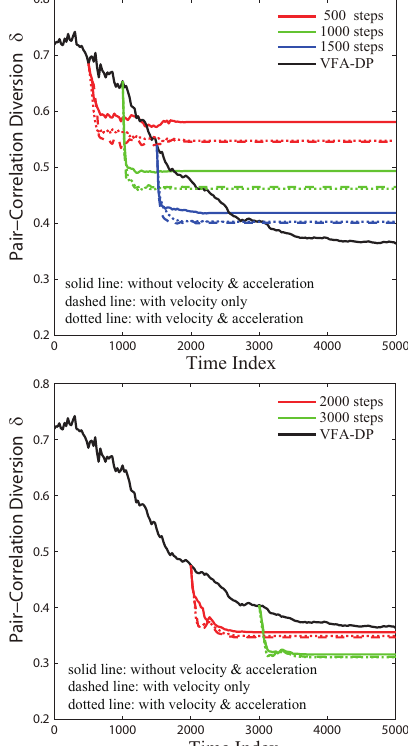
Figure 8. As specified in Figure 7, except taking into account the node acceleration in